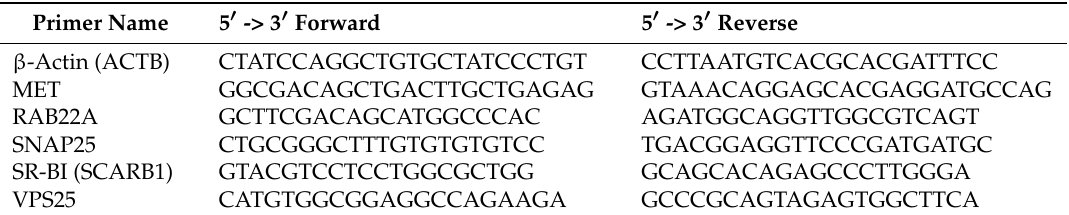
Table 1. Table of